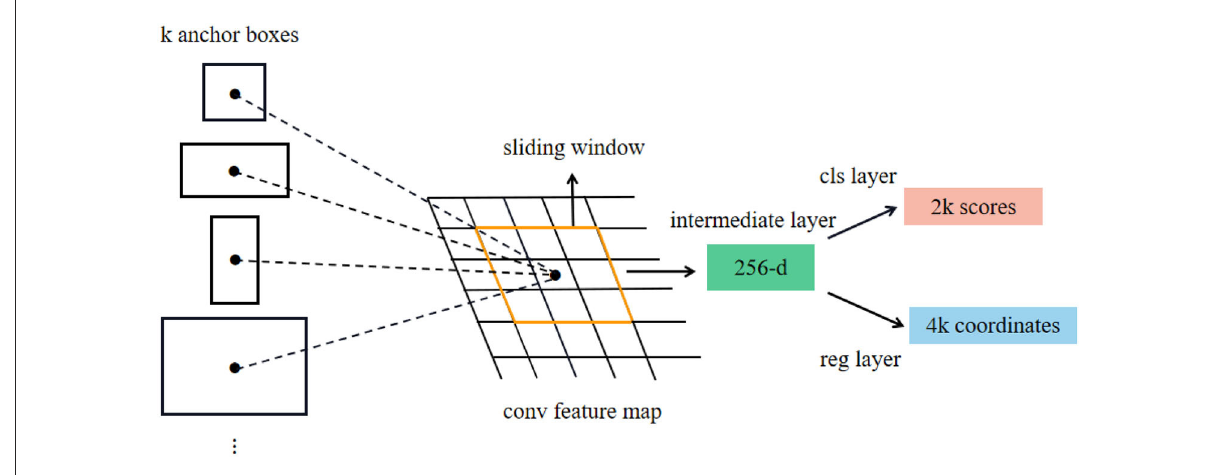
FIGURE5 Structure diagram of